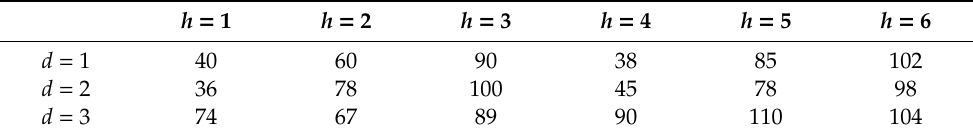
Table 7. Distance between distributors and hospitals.